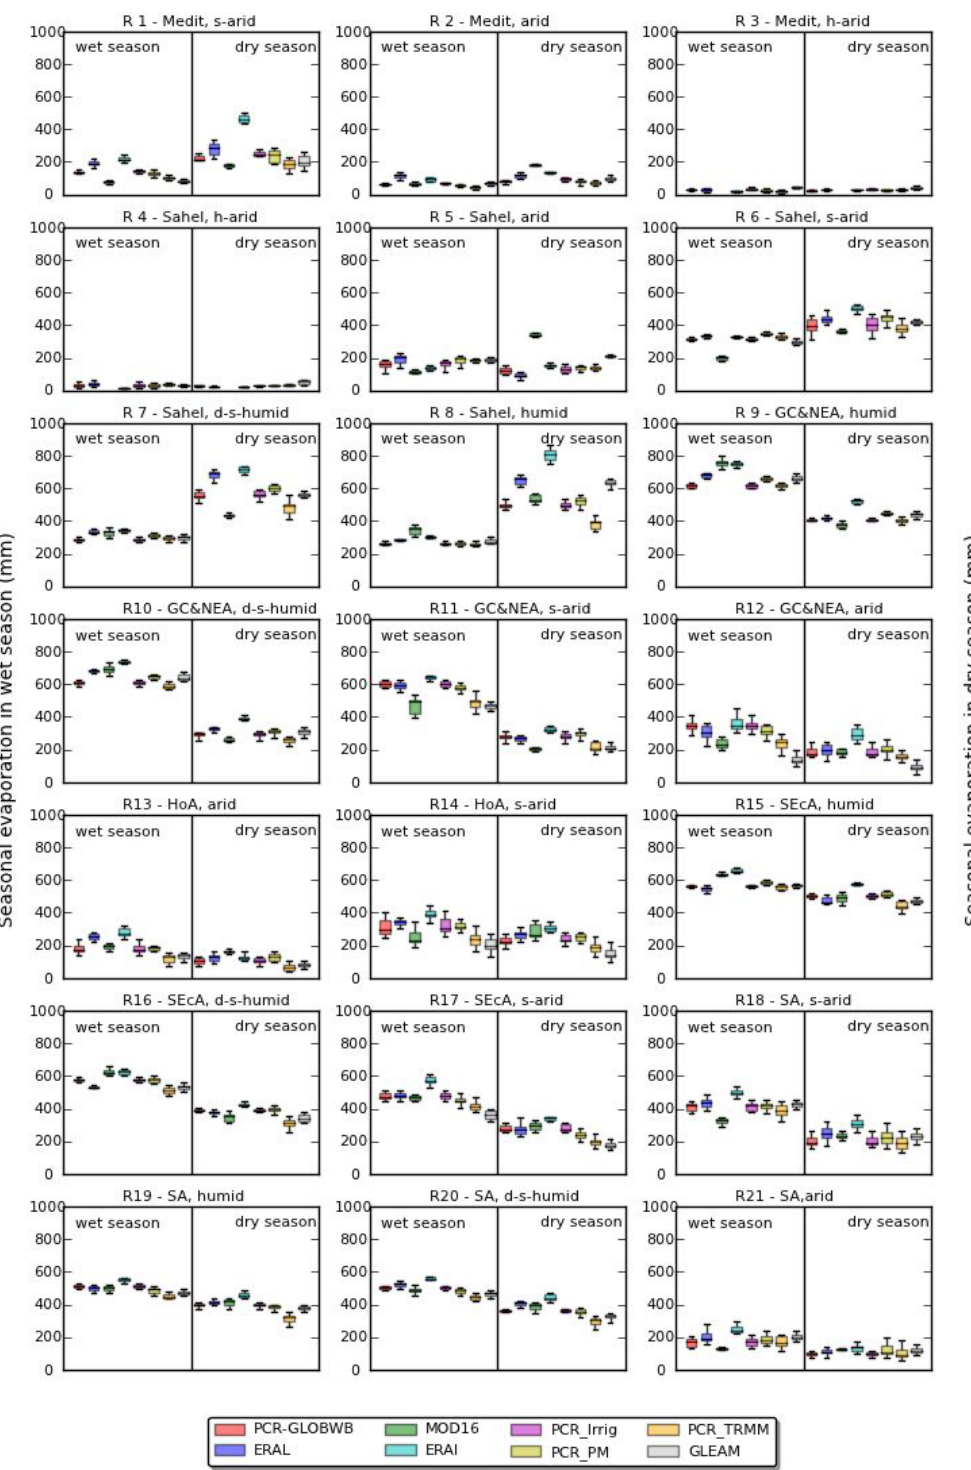
Fig. A1. Box plot diagrams of seasonal evaporation for each